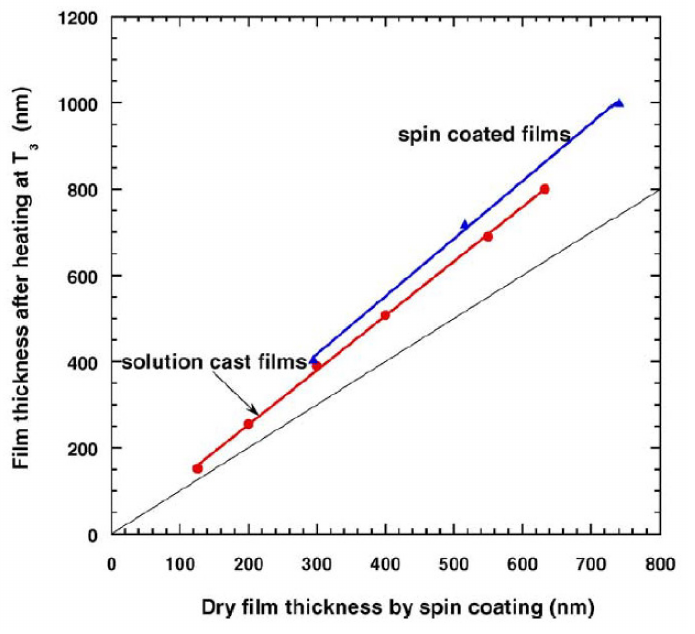
Figure 19. Final thicknesses of polysulfone thin films after heating above T g (used with copyright permission)